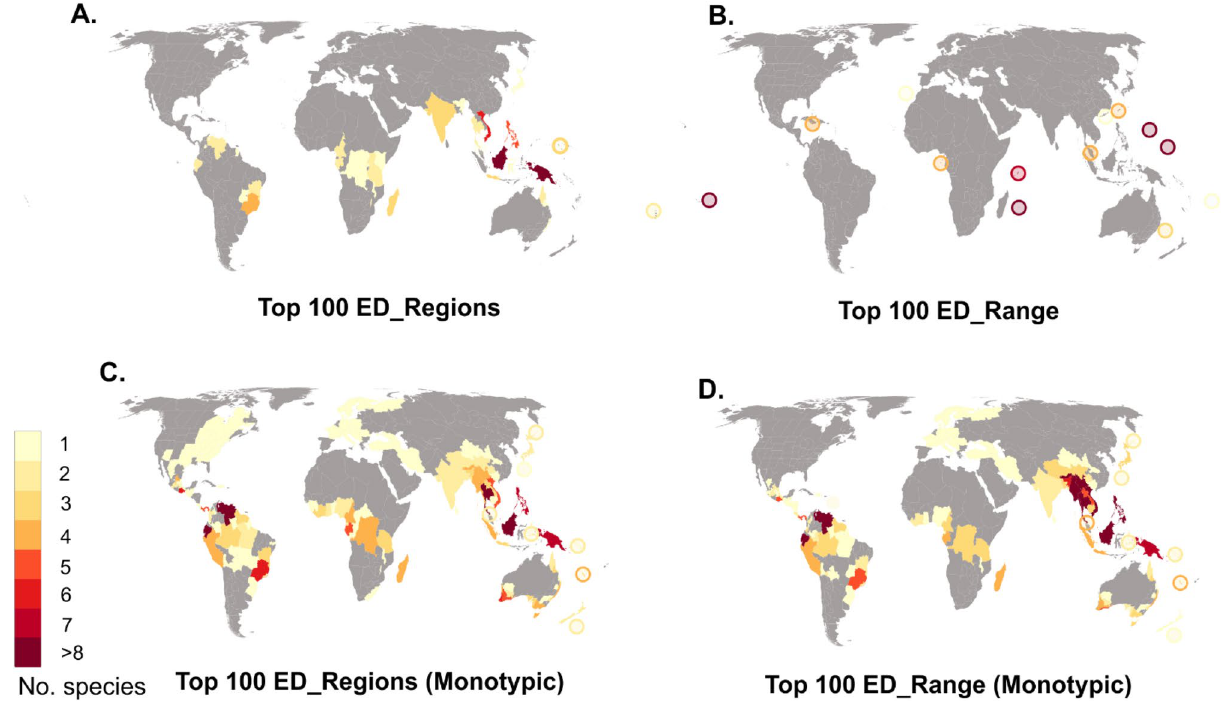
Figure 3. World maps highlighting centres of priority species based on several metric scores: ( A ) evolutionary distinctness rarity based on the number of regions species occupy (ED_Regions), ( B ) evolutionary distinctness rarity based on the range size of species (ED_Range), ( C ) monotypic genera and rarity based on the number of regions species occupy, and ( D ) monotypic genera and rarity based on the range size of species. All calculations, maps and other graphics were created using R 3.5.1, R Core Team. R software: Version 3.5.1. R Found. Stat. Comput. (2018) https:// doi. org/ 10. 1007/ 978-3- 540-